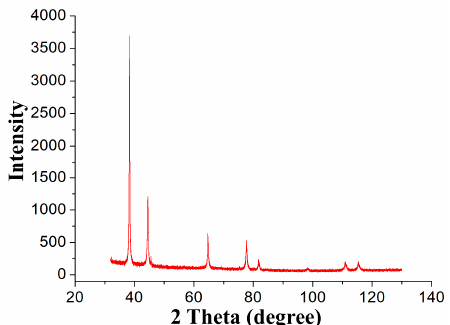
Figure 3. Representative XRD pattern of Au nano synthesized by electrodeposition in a 0.1 mM HAuCl 4 solution.